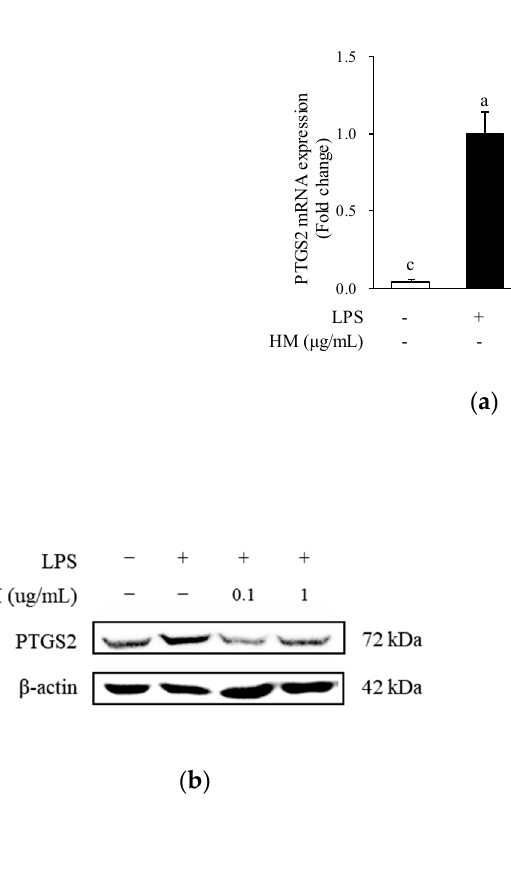
Figure 4. Effects of HM on protein and mRNA expression of PTGS2 in RAW264.7 cells. Cells were pre-incubated with indicated concentrations of HM for 1 h and then co-incubated with LPS (1 μ g/mL) for 24 h. ( a ) PTGS2 mRNA levels were determined by qRT-PCR. ( b ) Representative images of western blots. ( c ) PTGS2 protein levels quantified by ImageLab software. Values are expressed as mean ± SEM ( n = 4). Different superscript letters indicate statistical significance ( p < 0.05). PTGS2, prostaglandin-endoperoxide synthase 2; LPS, lipopolysaccharide; HM, high hydrostatic pressure extract of mulberry fruit.